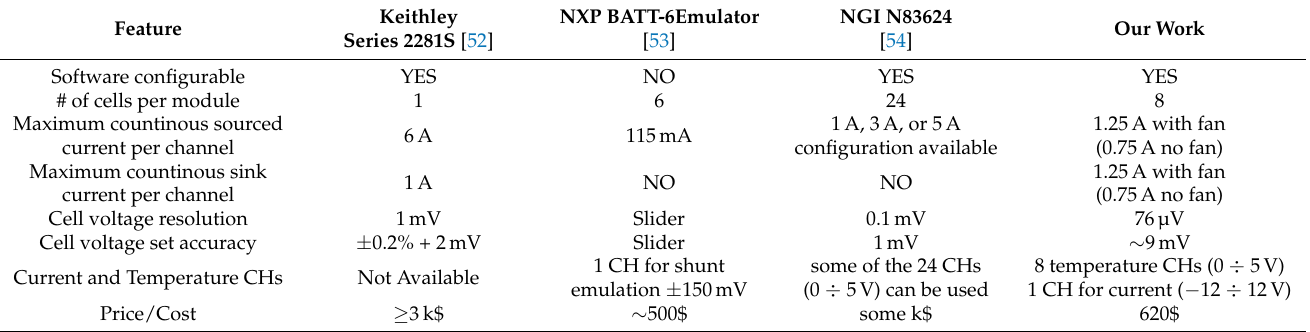
Table 4. Feature comparison of our work with commercial